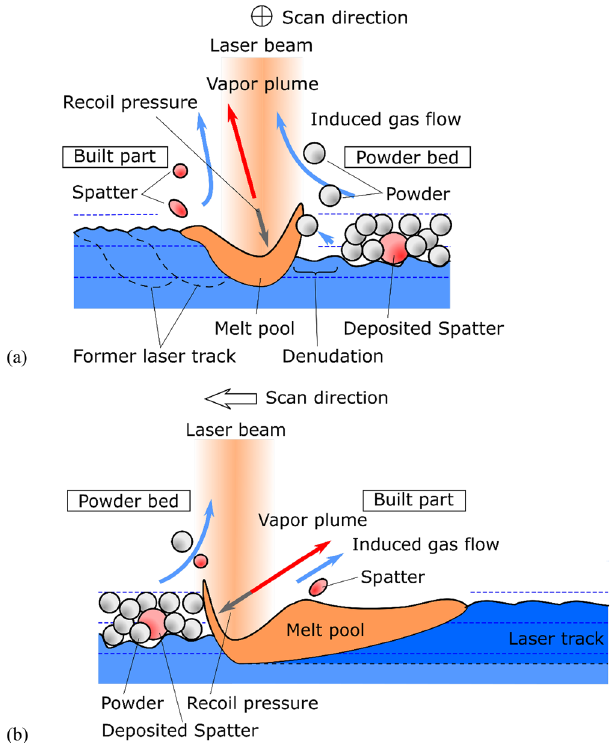
Figure 7. Schematic of the melt pool behavior and spatter formation. ( a ) The transverse section of the laser scan direction and ( b ) longitudinal section; melt pool length is shortened because of space